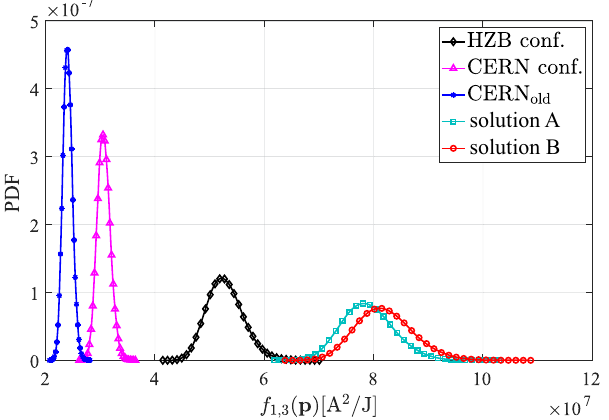
FIG. 13. Probabilistic density function for the ratio of the magnetic peak values.